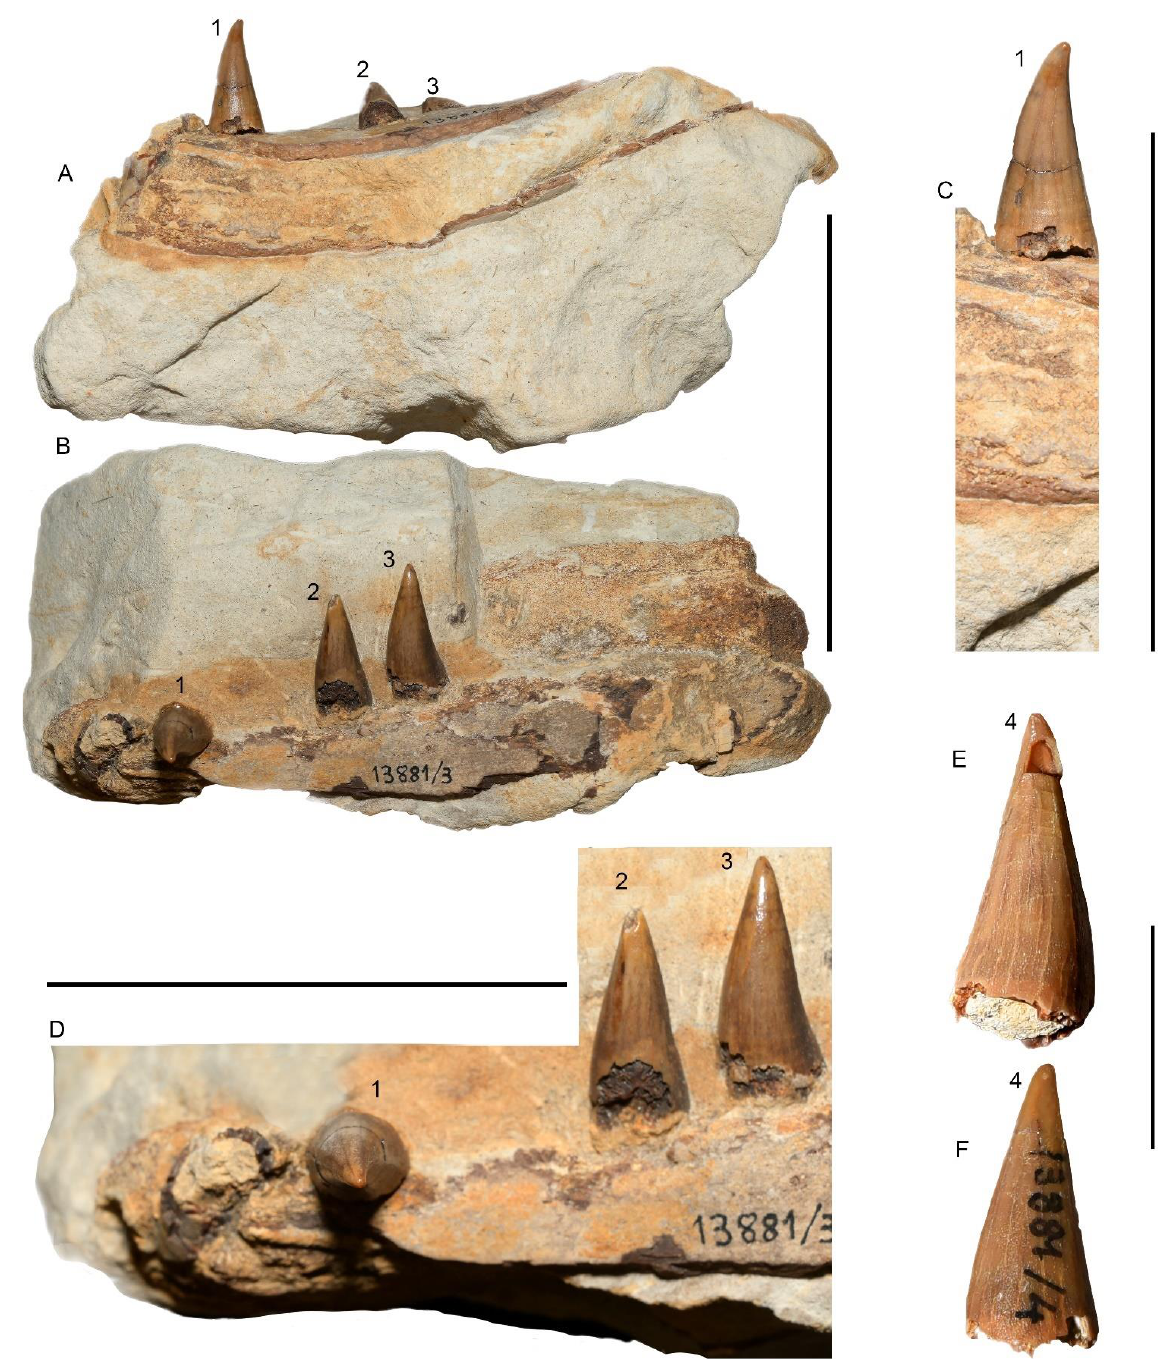
Figure 3. Dentition and mandibular fragments MGPT-PU 13881/3-4. ( A ) fragment with three teeth in ventral view (MGPT-PU 13881/3). ( B ) The same in lateral view. ( C ) Close-up view of the most anterior tooth (tooth 1) of those illustrated in ( A ). ( D ) Close-up view of the more posterior couple of teeth (teeth 2 and 3) of those illustrated in ( A ). Scale bars in ( A – D ) equal 5 cm. ( E ) Close-up view of MGPT-PU 13881/4 showing tooth 4 in lingual view. Scale bar in ( E ) equals 2 cm. ( F ) the same tooth in labial view.